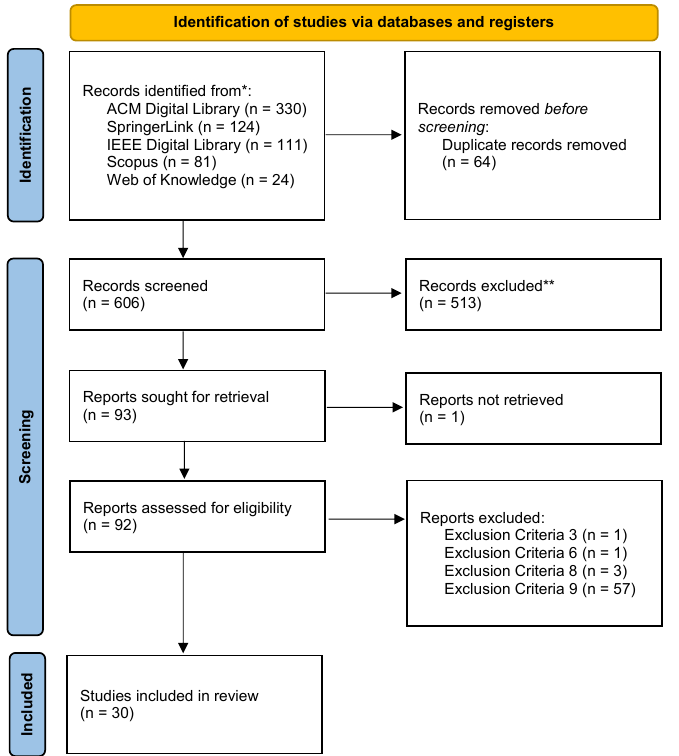
Figure 4. The systematic review’s pipeline and number of papers selected at each step, shown as the PRISMA flow